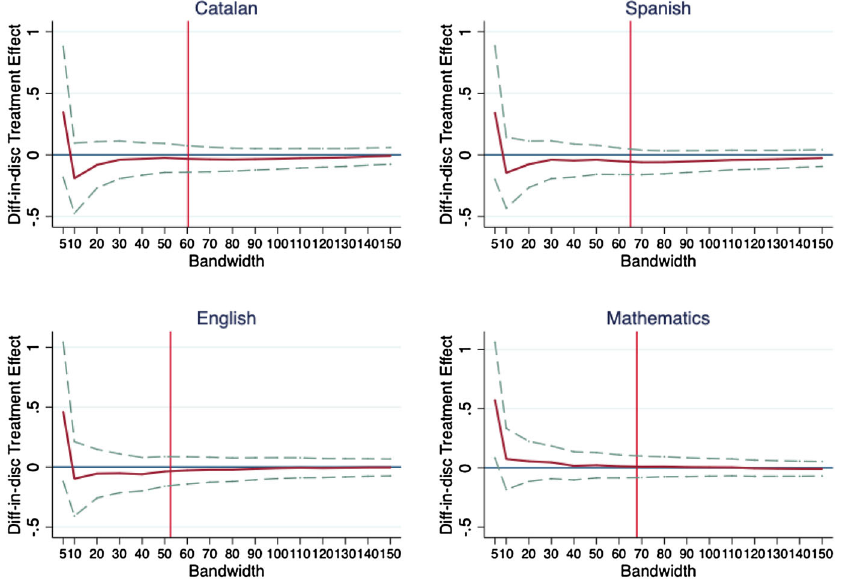
Fig. 6 Diff-in-disc sensitivity to bandwidth choice, pooled sample. Note : 95% confidence interval in dashed lines. The vertical line indicates the optimal bandwidth from Table